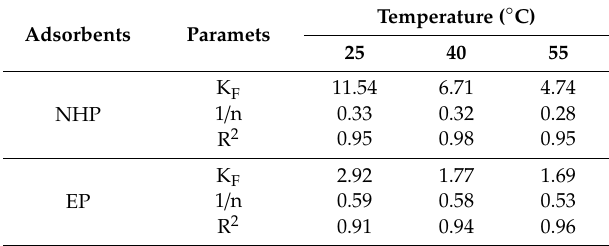
Table 3. Freundlich isotherm parameters for EGCG adsorption onto processed pomelo peel at di ff erent